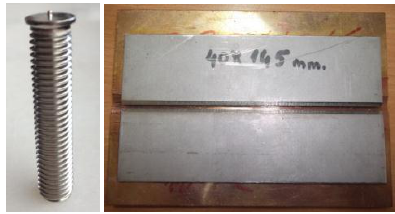
Figure 3. AISI 304 austenitic studs with S32205 Duplex plates.